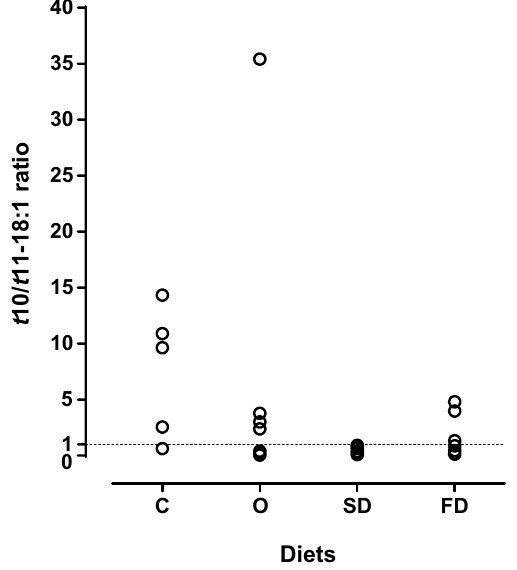
Figure 4. Dispersion of individual values of t 10/ t 11-18:1 ratio in the rumen of lambs fed experimental diets. Diets are represented as follow: C (Control), O ( Nannochloropsis sp . oil), SD (spray-dried N. oceanica ) and FD (freeze-dried N. oceanica ). Least square means are presented in each point.